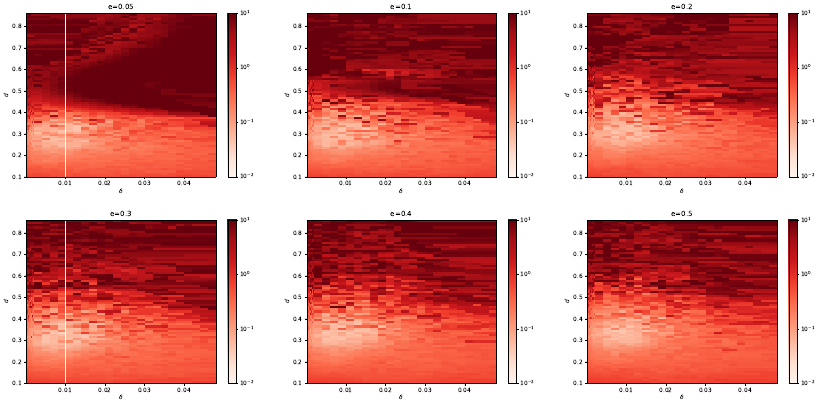
Figure 2. Maximum deviation from exact solution of the sine-Gordon equation with c = 1 − 5 · 10 − 5 at J = 4 using the adaptive grid (2.4) for various grid parameters. The sine-Gordon equation (4.5) was numerically solved at J =4 with pa- rameter values varying from d =0 . 1 , 0 . 11, . . . , 0 . 85, e =0 . 05 , 0 . 1 , 0 . 2 , 0 . 3 , 0 . 4 , 0 . 5 and 0 . 001 < δ < 0 . 05. The maximum deviation from the exact solution (4.6) was calculated and compared between the various numerical experiments. Such numerical results are shown in Figure